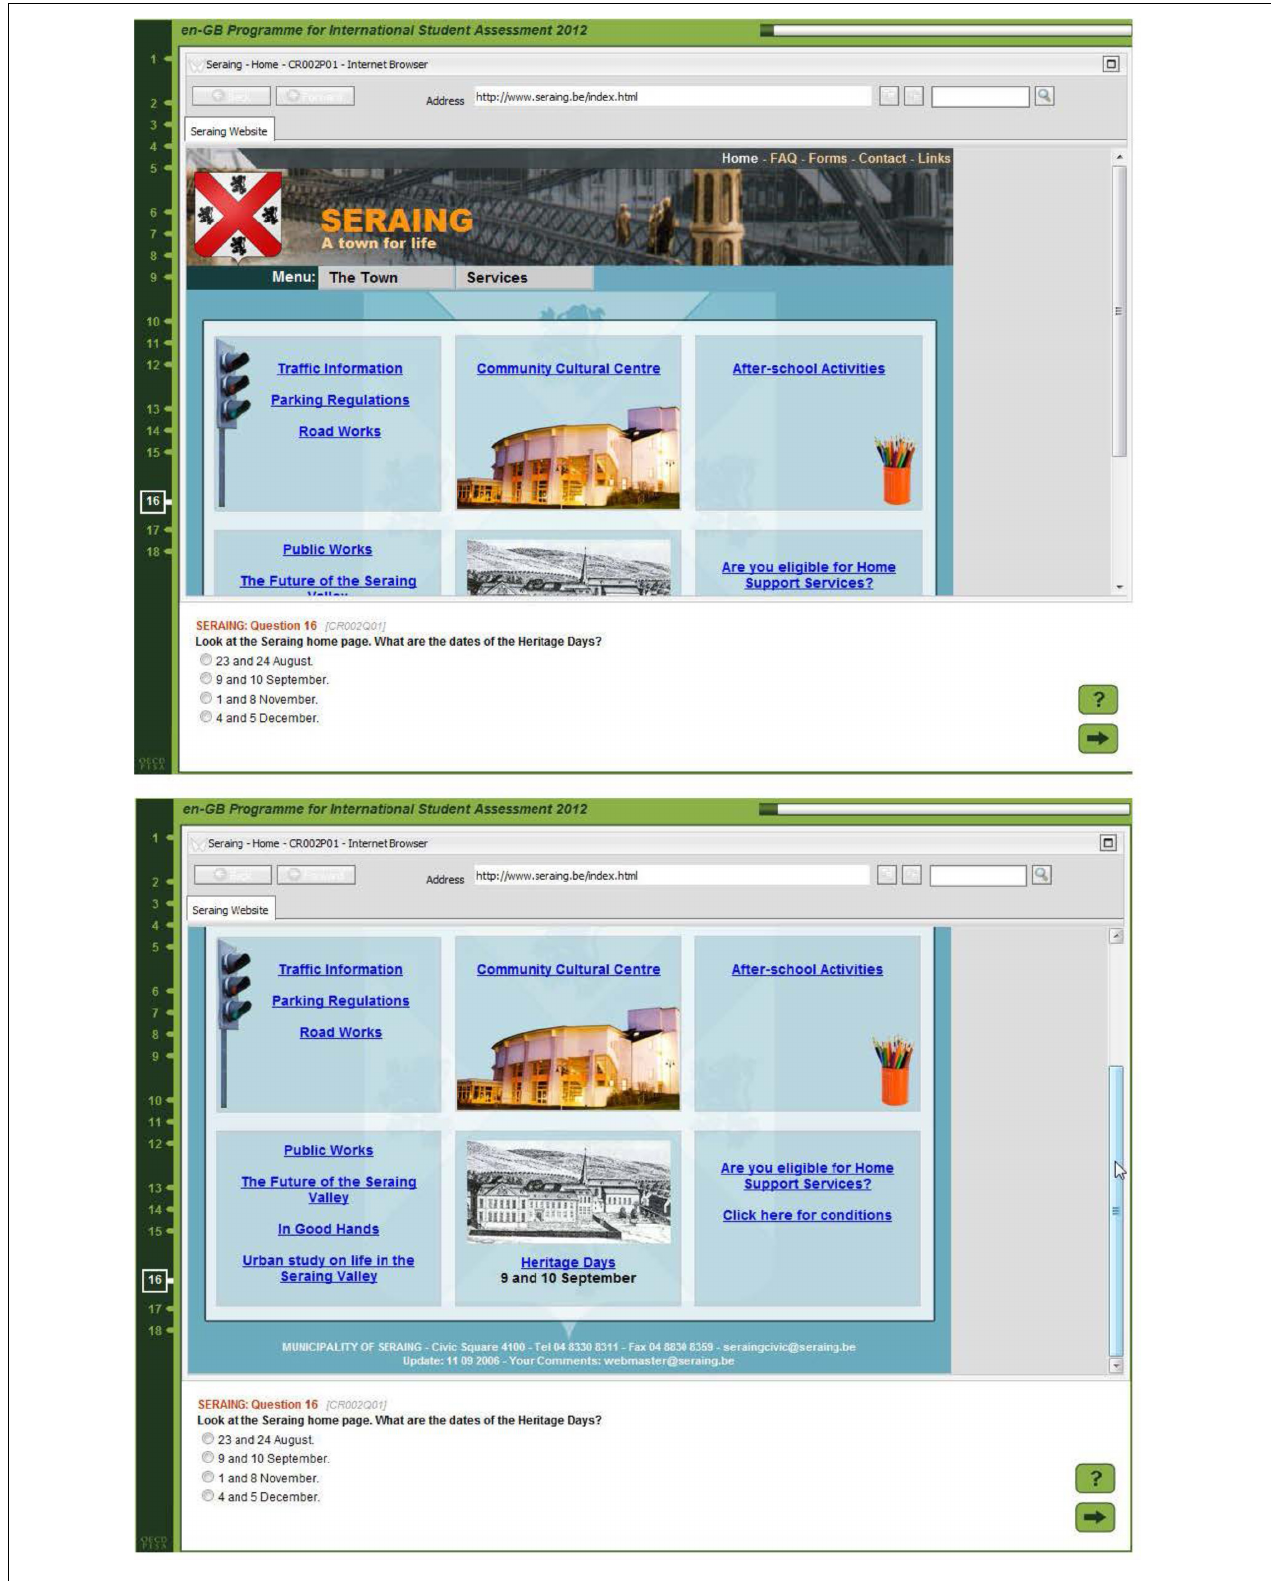
FIGURE 2 | Two screenshots from a simple digital reading task requiring minimal navigation (scrolling) only (see OECD, 2011, 2015).